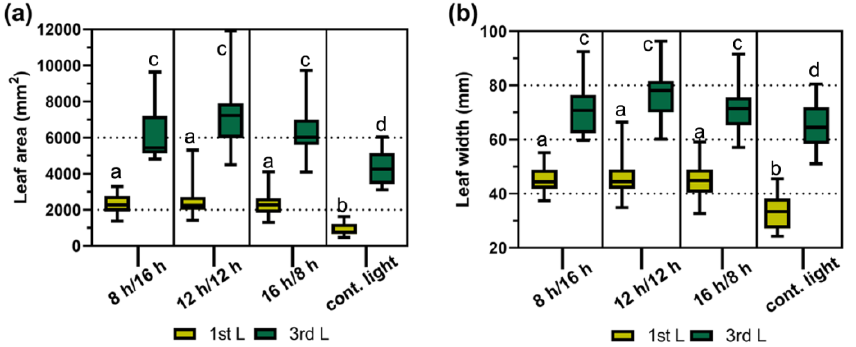
Figure 1. Influence of day length on the size of the 1st and 3rd leaf of B. juncea plants. ( a ) Leaf area; ( b ) leaf width. Plants were grown under different day-length regimes simultaneously. The columns represent the mean values ± min./max. obtained from measurements of 20 – 24 leaves per photoperiod ( n = 20 – 24). Different letters indicate a significant difference between the means according to Duncan ’ s test ( p < 0.05). Abbreviations: L, leaf; 8 h/16 h, 8 h day/16 h night; 12 h/12 h, 12 h day/12 h night; 16 h/8 h, 16 h day/8 h night; cont. light, continuous light (24 h day/0 h night).